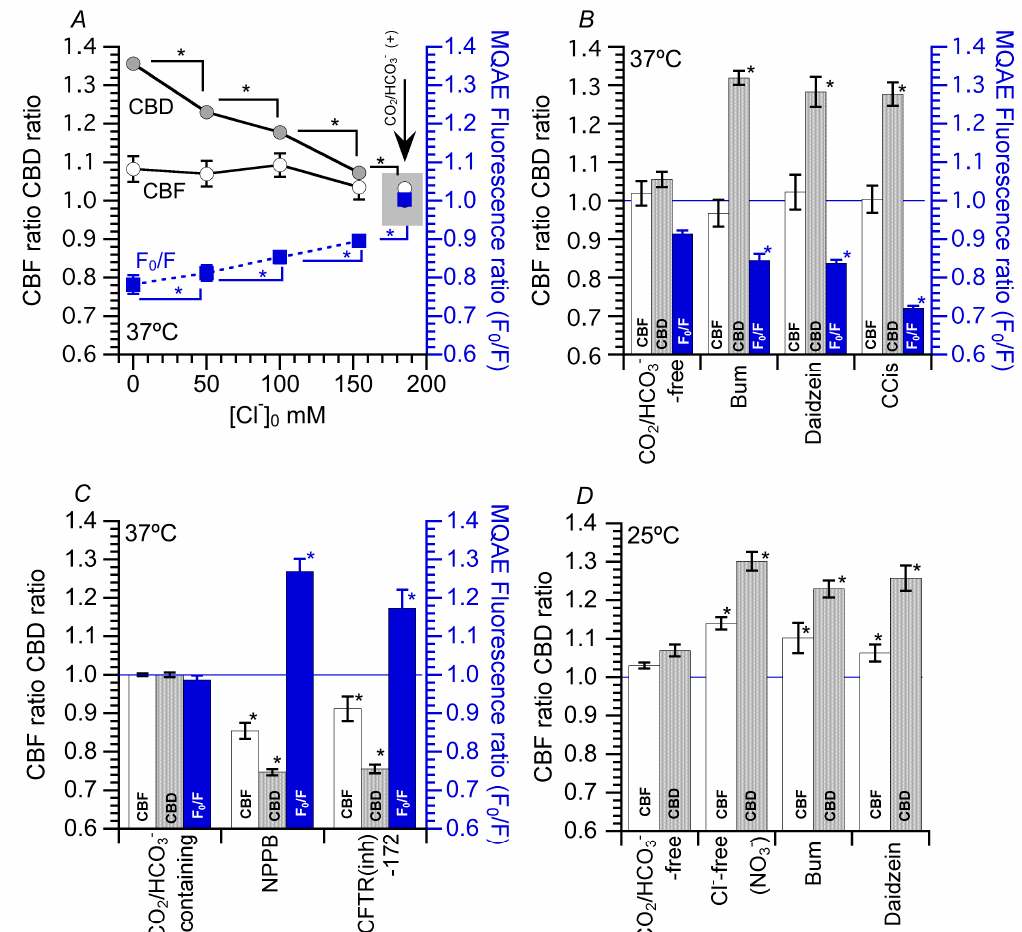
Figure 5. Effects of decreased intracellular Cl − ([Cl − ] i ) on ciliary beat frequency (CBF) and ciliary beat distance (CBD). ( A ) Effects of Cl − -free (NO 3 − ) solution on CBF, CBD and fluorescence ratio (F 0 /F) of N-ethoxycarbonylmethyl-6-methoxyquinolinium bromide (MQAE). First, the perfusion solution was switched from a CO 2 /HCO 3 − -containing solution to a CO 2 /HCO 3 − -free solution. This switch decreased F 0 /F (decrease in [Cl − ] i ) due to Na + -HCO 3 − cotransporter and Cl − /HCO 3 − exchange inhibition. The decreasing extracellular Cl − concentration ([Cl − ] o ) decreased [Cl − ] i . The decreased levels of F 0 /F were dependent on [Cl − ] o . The decreases in [Cl − ] i increased CBD, the levels of which are dependent on [Cl − ] i . However, a decreased [Cl − ] i did not increase CBF. ( B ) Effects of bumetanide (bum), daidzein and carbocisteine (CCis) on CBF, CBD and F 0 /F ([Cl-] i ). Experiments were performed in a CO 2 /HCO 3 − -free solution. Bum, daidzein and CCis decreased F 0 /F, indicating decreases in [Cl − ] i . These decreases in [Cl − ] i increased CBD, but CBF remained unchanged. ( C ) Effects of Cl − channel blockers on CBF, CBD and F 0 /F ([Cl − ] i ). 5-nitro-2-(3-phenylpropylamino)benzoic acid (NPPB) and a cystic fibrosis transmembrane conductance regulator inhibitor (CFTR(inh)-172) increased F 0 /F ([Cl − ] i ). Increases in [Cl − ] i (F 0 /F) decreased both CBF and CBD. ( D ) Effects of Cl − -free (NO 3 − ) solution, bum, daidzein and CCis on CBF and CBD at 25 °C. Unlike at 37 °C, Cl − -free (NO 3 − ) solution, bum, daidzein and CCis increased both CBF and CBD. Thus, a decrease in [Cl − ] i enhances both CBF and CBD at 25 °C. * indicates results significantly different from the control values ( p < 0.05). Error bars indicate SE.